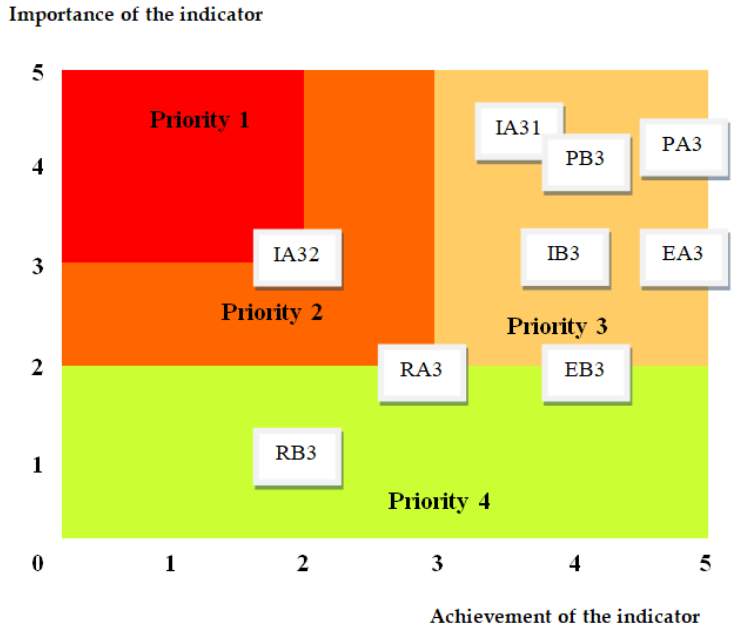
Figure 6. Labor practices sustainability assessment diagram.